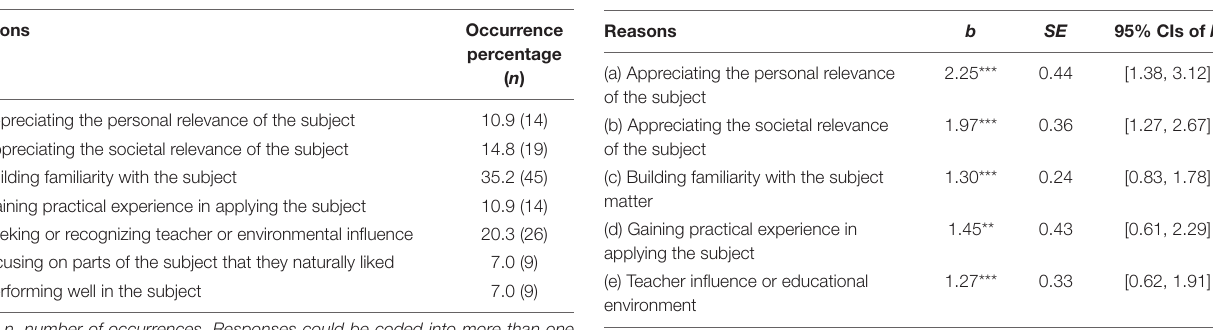
TABLE 2 | Study 1 linear regression results from predicting passion change scores with students’ reported use of each category of strategy in separate